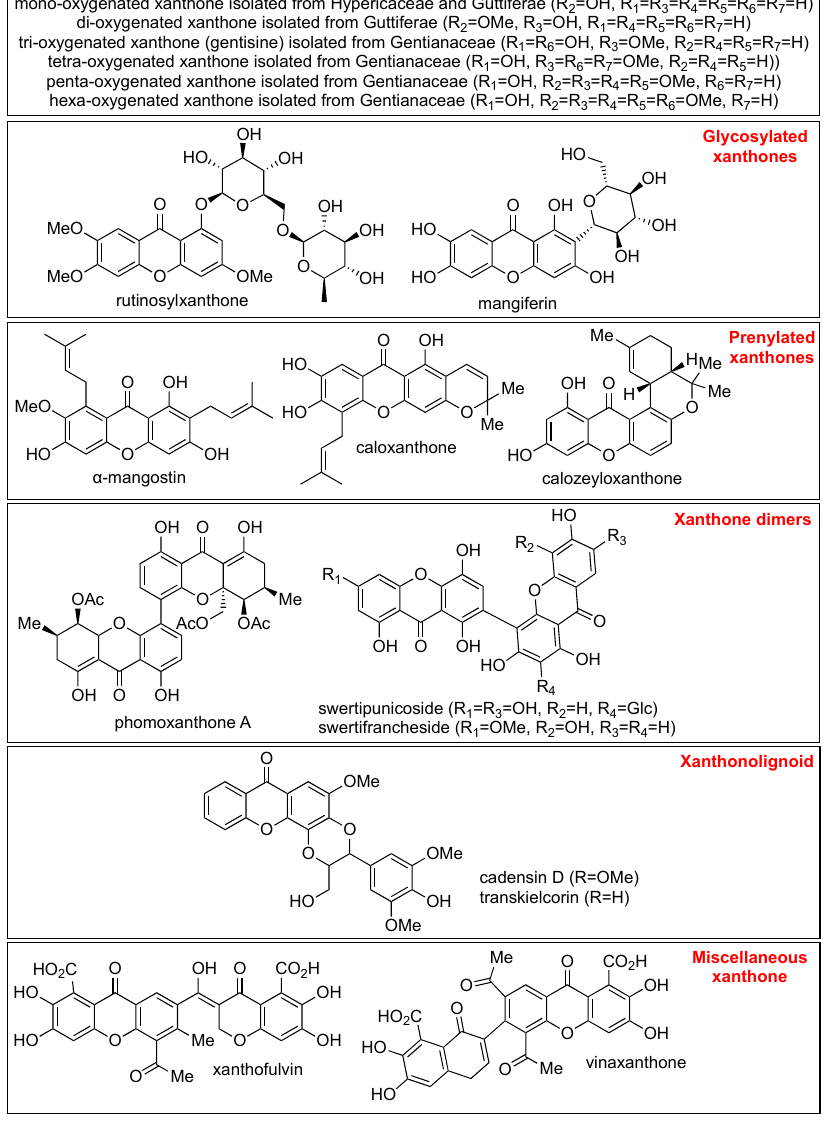
Figure 2. Classification of xanthone derivatives with some examples for each group.